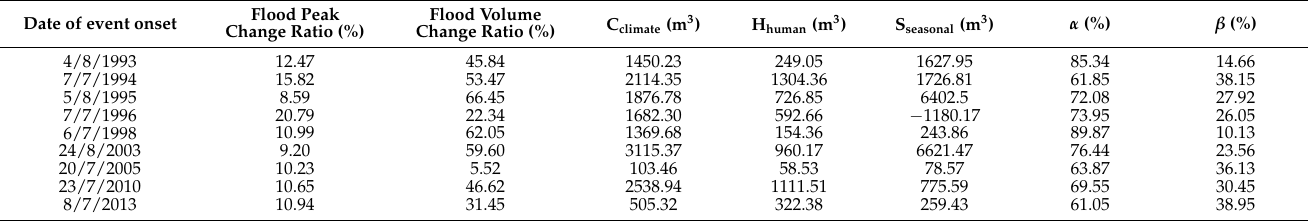
Table 8. Quantitative calculation of the influence of climate change and LUCC on floods in the